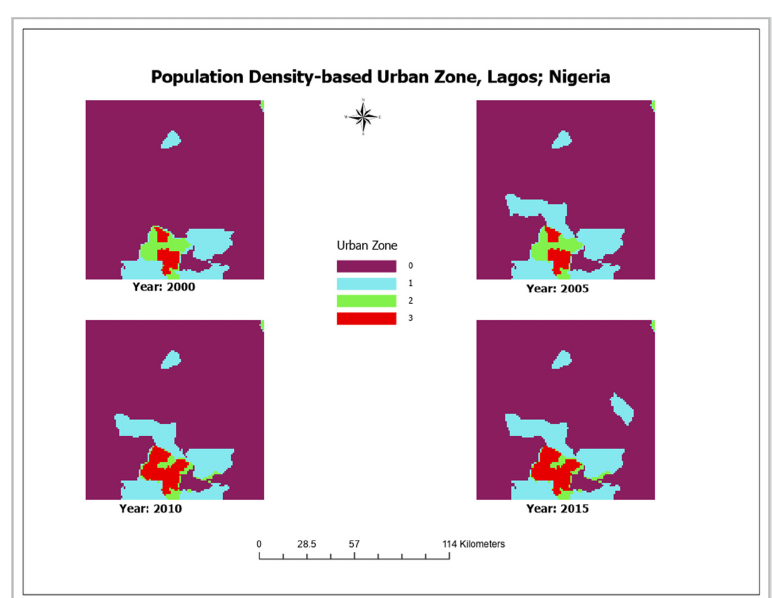
Figure 7. Gridded population density-based zones over study area.